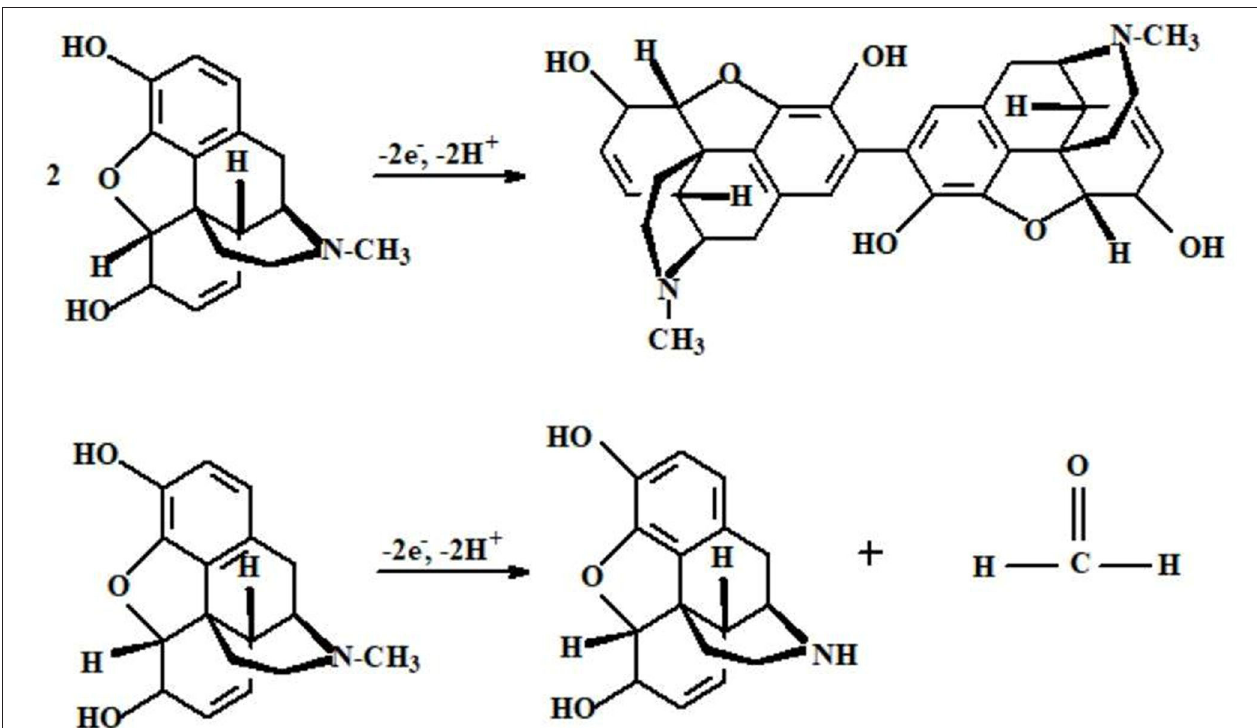
FIGURE 3 | The oxidation mechanism of morphine. Reproduced from Navaee et al.